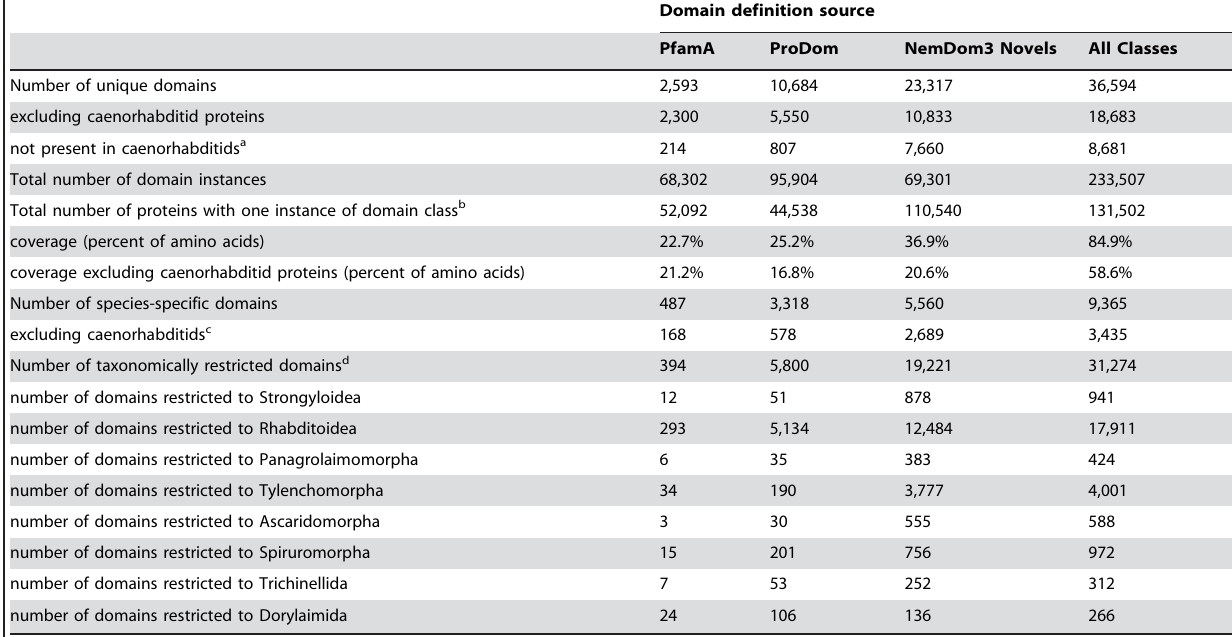
Table 2. The domain content of nematode